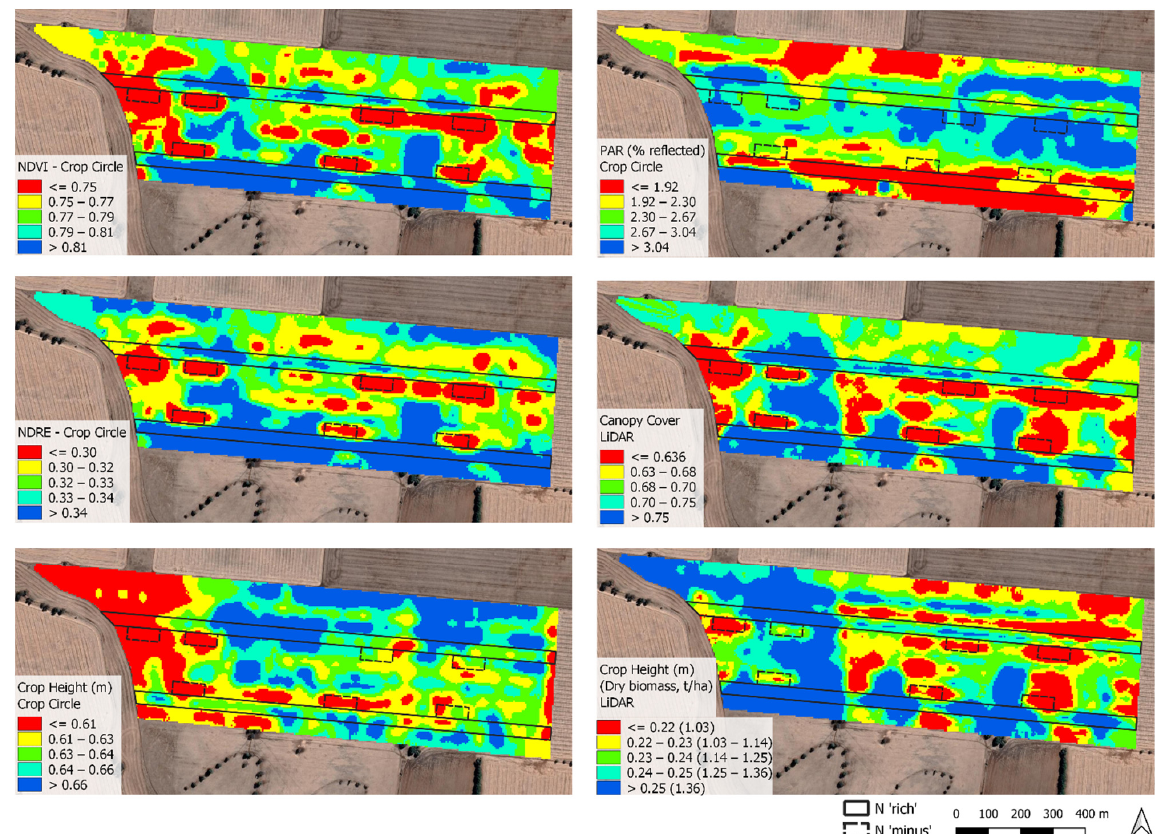
Figure 7. Maps derived from Crop Circle and LiDAR sensors in a 64-ha commercial wheat field in South Australia. Colour classes are divided by quantiles (i.e., 20th percentiles). Biomass values (bottom right map, shown in brackets) were converted from LiDAR-derived crop height values using a calibrated model (Figure 9).